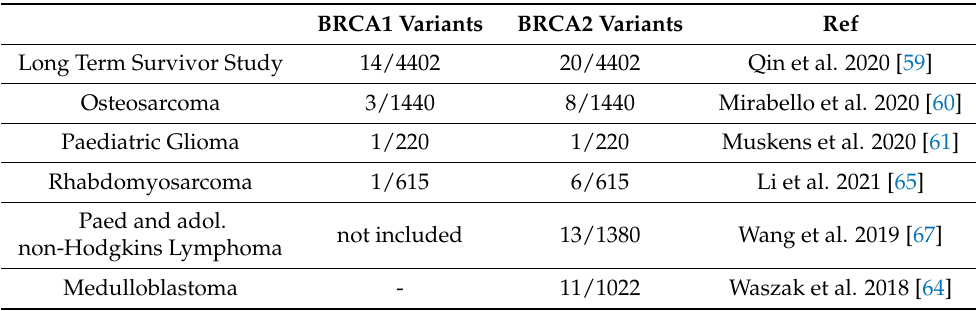
Table 1. Frequency of BRCA1 and BRCA2 variants in large-scale germ line studies in childhood and adolescent